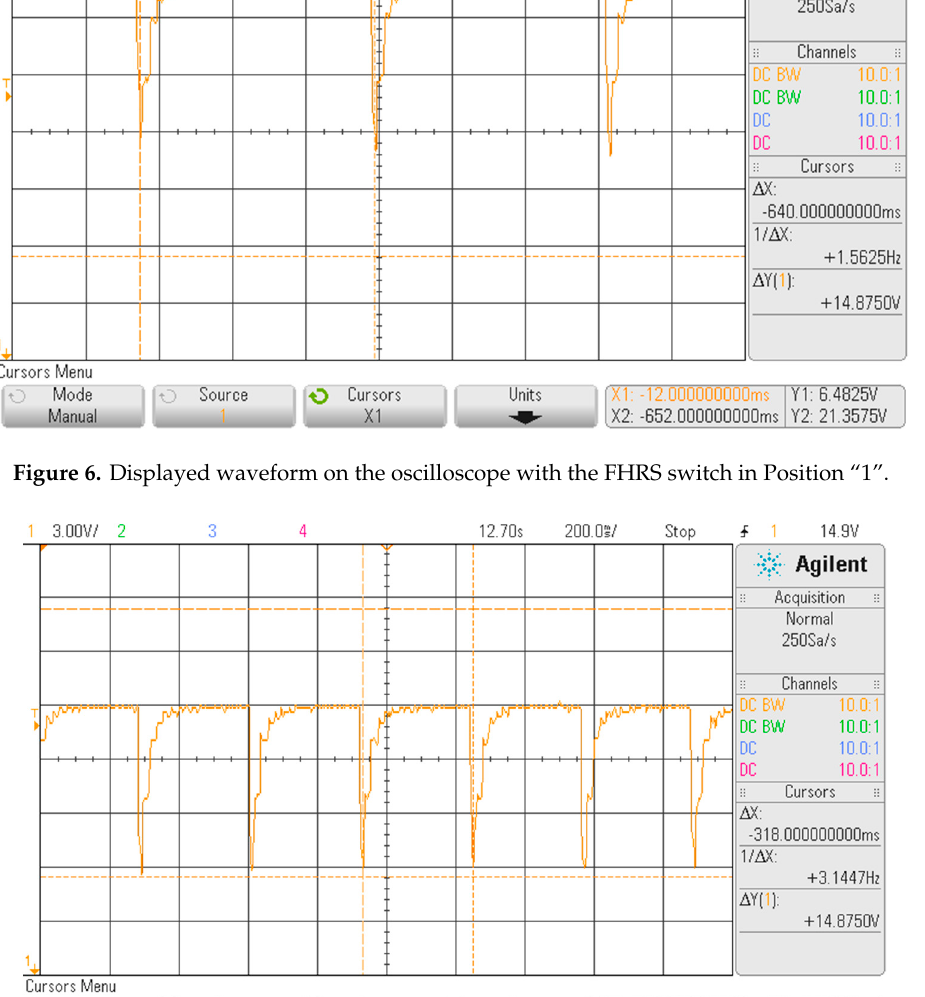
Figure 6. Displayed waveform on the oscilloscope with the FHRS switch in Position “1”.